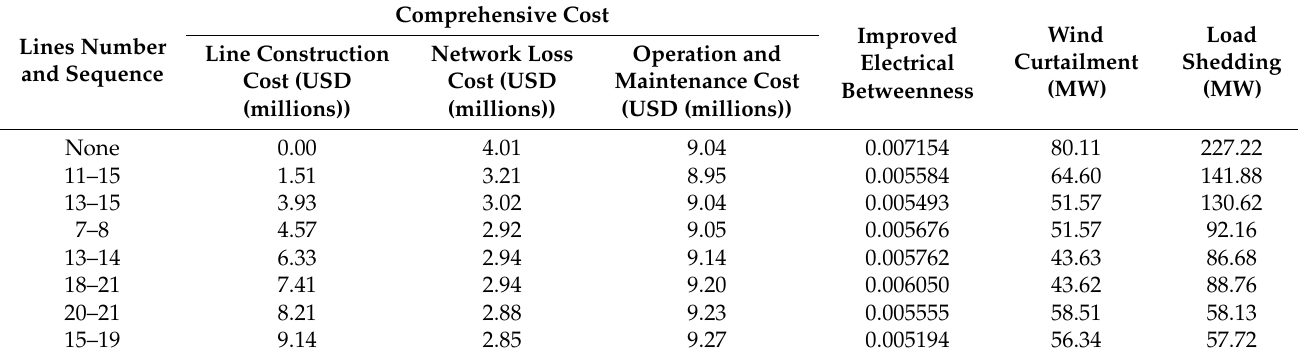
Lines Number and